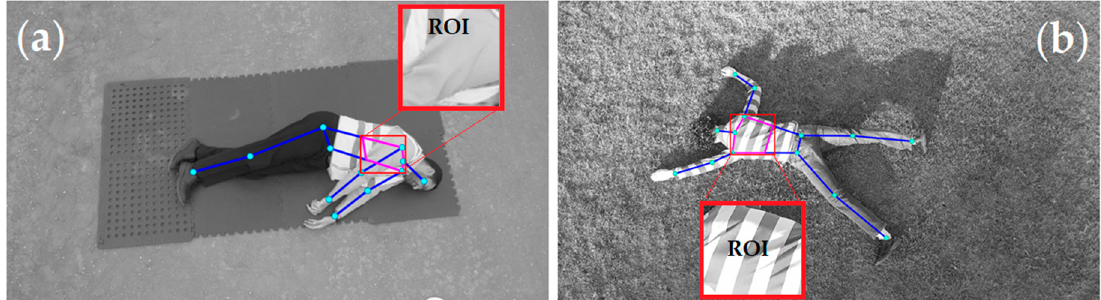
Figure 4. ROI selection based on OpenPose approach where the chest region was selected by drawing a bounding box (red) around the upper torso (magenta) for ( a ) a human subject, ( b ) a mannequin. Thirdly, the luminance pixel values over the image sequences of the selected ROI from the Y component were averaged as follows: